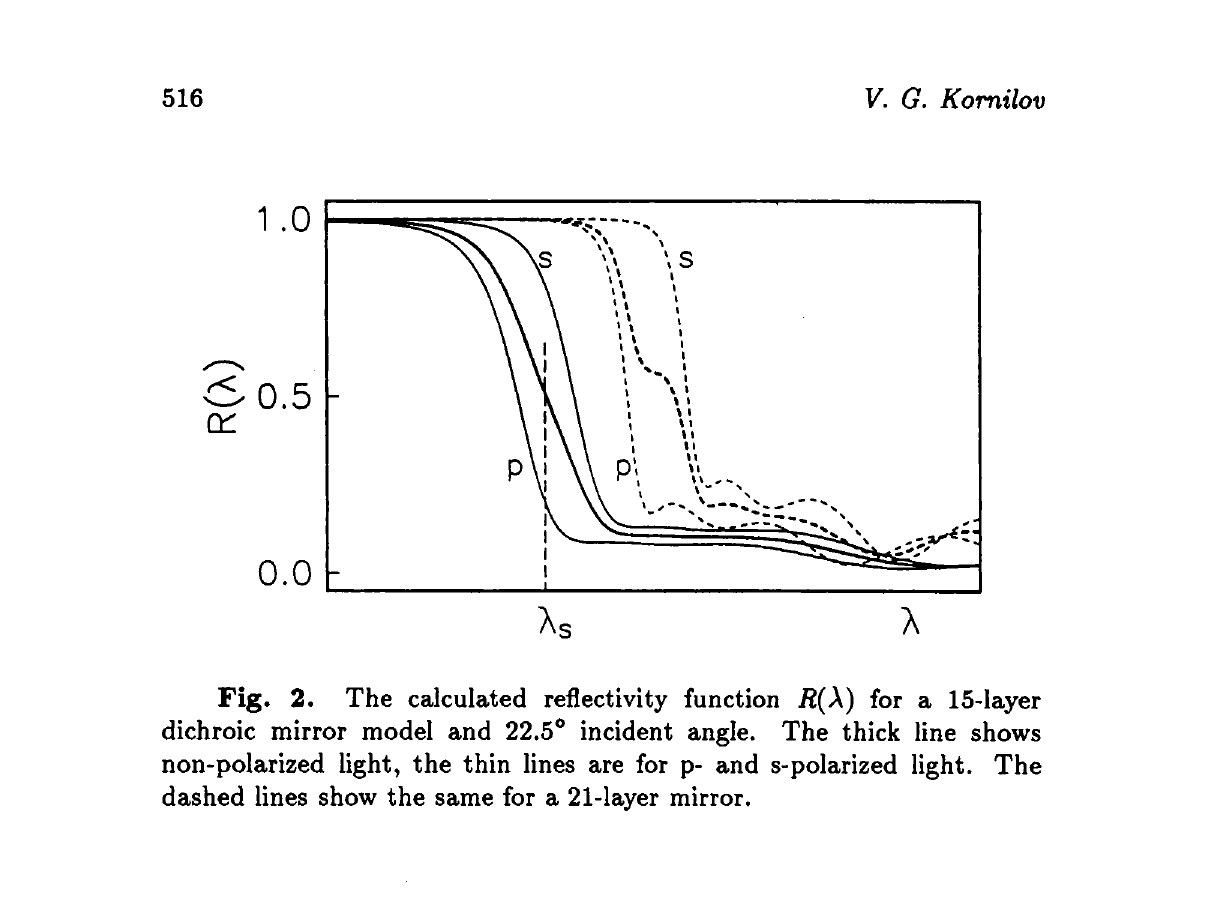
Fig. 2. The calculated reflectivity function R{ A) for a 15-layer dichroic mirror model and 22.5° incident angle. The thick line shows non-polarized light, the thin lines are for p- and s-polarized light. The dashed lines show the same for a 21-layer